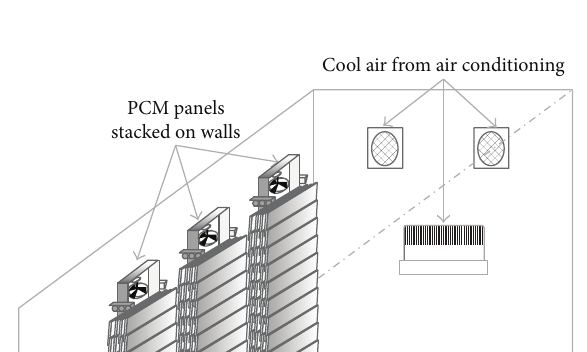
Figure 13: Cross-sectional view of the roof (a) with PCM panel and (b) without PCM panel.